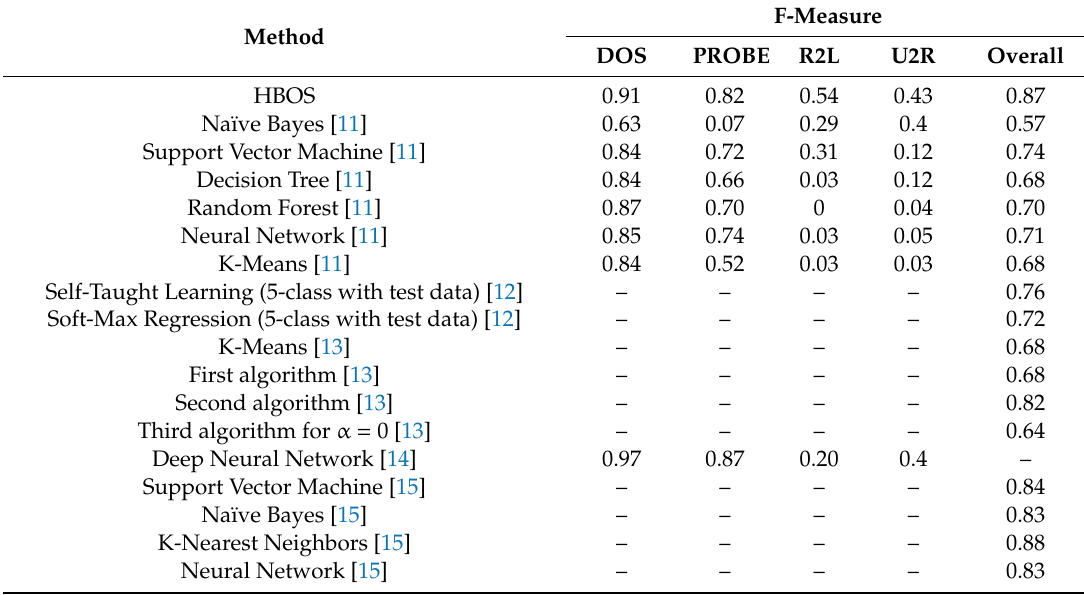
Table 2. Comparison of F-measure results with related works.